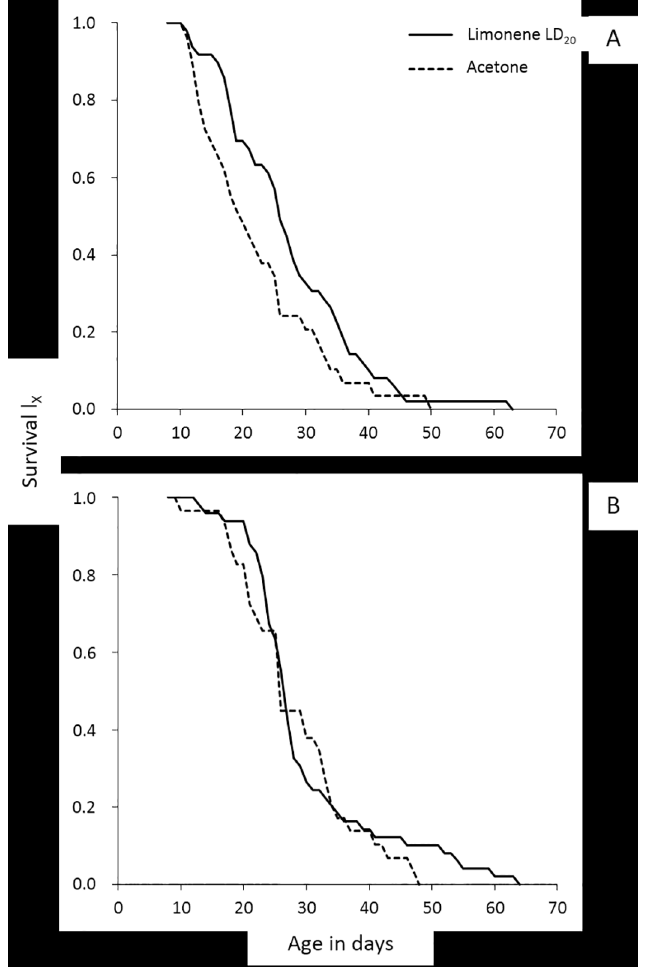
Fig 1. Age-specific survival curves for females that fed with S (A) or YS (B) and were subjected to limonene LD 20 or to pure acetone